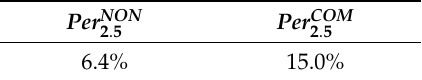
Table 5. Percentages of ‘high exposure’ activities for non-commuting and commuting cycling